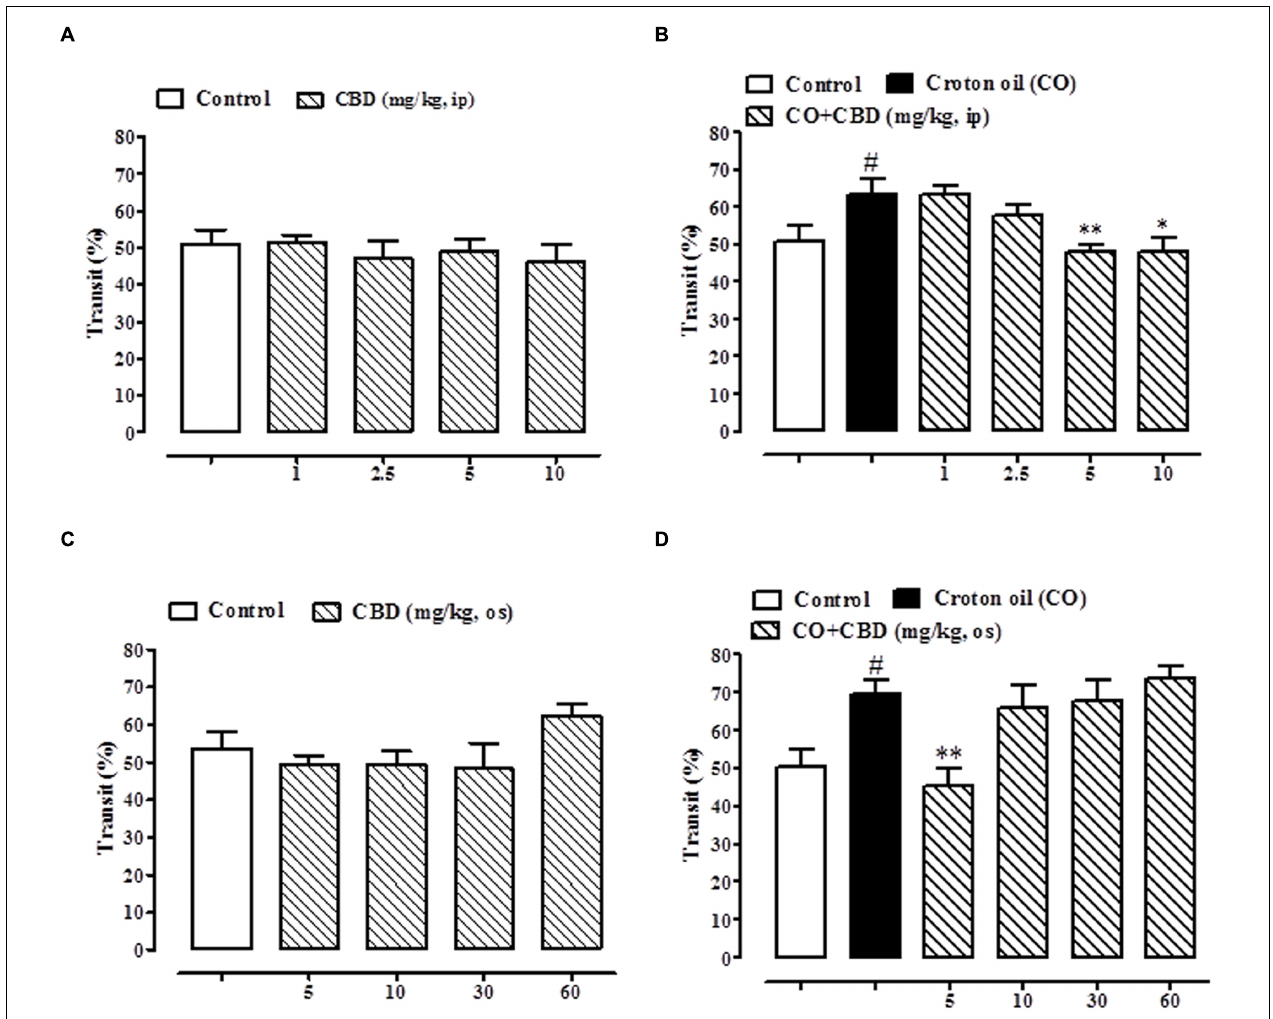
FIGURE 6 | Effect of intraperitoneal administration of pure CBD (1–10 mg/kg) on intestinal transit in healthy mice (A) and croton oil-treated mice (B), and oral gavage administration of pure CBD (5–60 mg/kg) on intestinal transit in healthy mice (C) and croton oil-treated mice (D). Bars represent the mean ± SEM of 8–10 animals for each experimental group. # p < 0.05–0.01 vs. control; ∗ p < 0.05 and ∗∗ p < 0.01 vs. croton oil